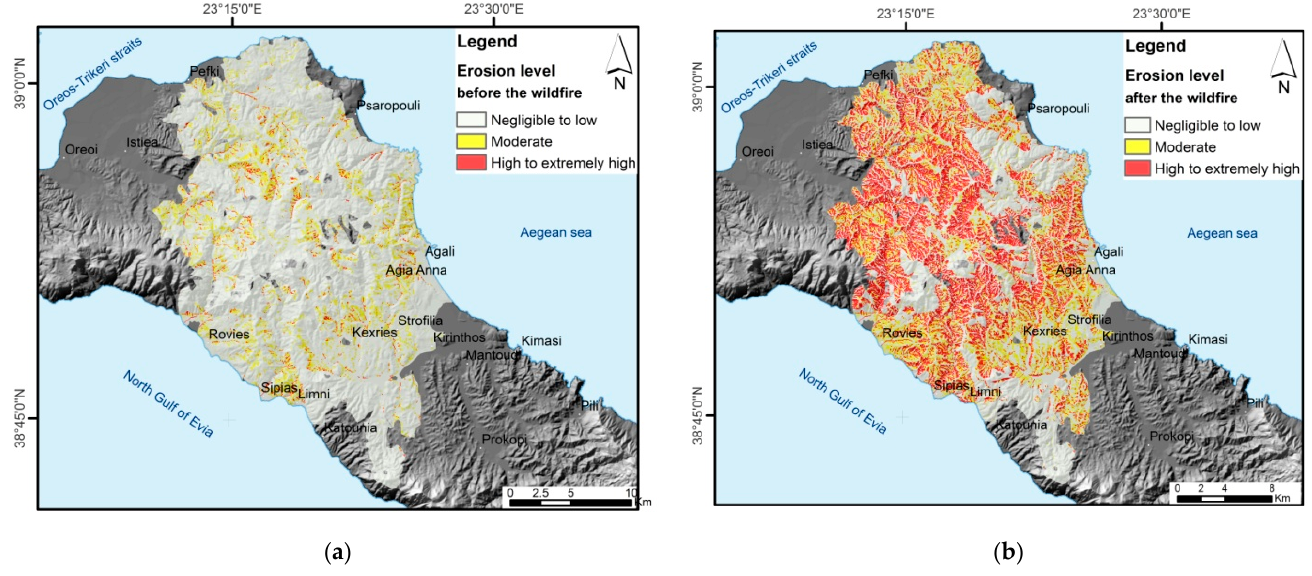
Figure 9. Erosion level mapping in the fire-affected sub-area ( a ) before the wildfire and ( b ) after the wildfire.